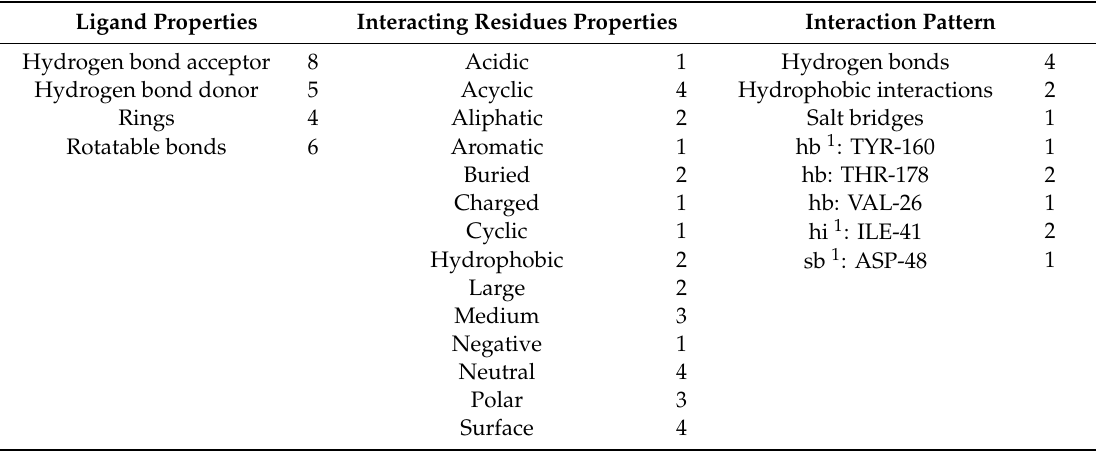
Table 1. Main interactions of the trimetrexate- Tc DHFR-TS